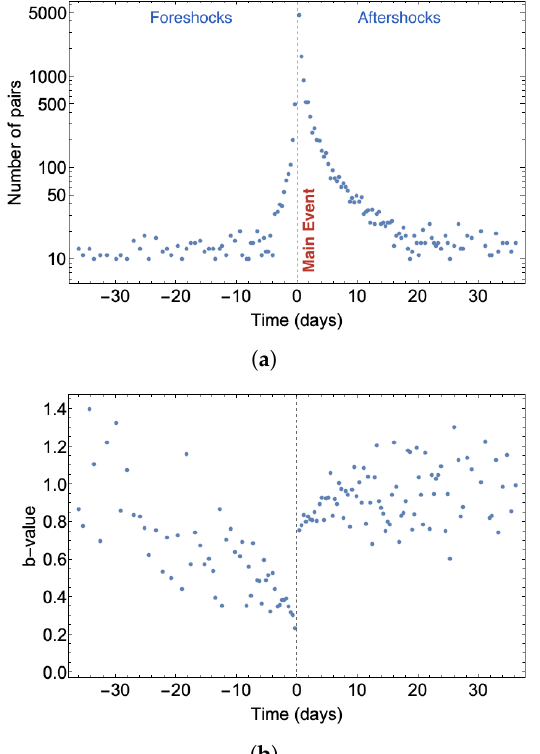
Figure 8. ( a ) Stacked number of M w ≥ 4.2 earthquakes that preceded and followed an M w ≥ 5.2 earthquake within an epicentral distance of 50 km in 100,000 years simulated catalog, zooming on a time scale spanning only 0.1 years (36.5 days); ( b ) average b-value in time bins of 0.365 days before and after an earthquake of M w ≥ 5.2 containing at least 10